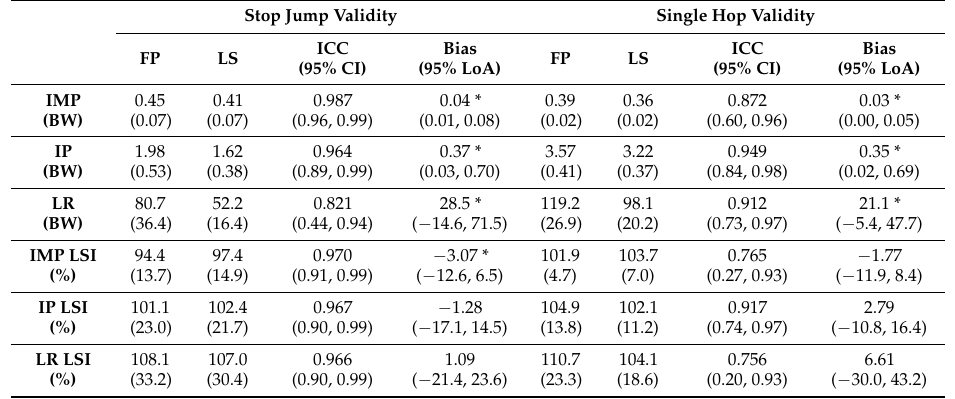
Table 2. Validity of loadsol insole sensors during the stop jump and single hop tasks collected at 200